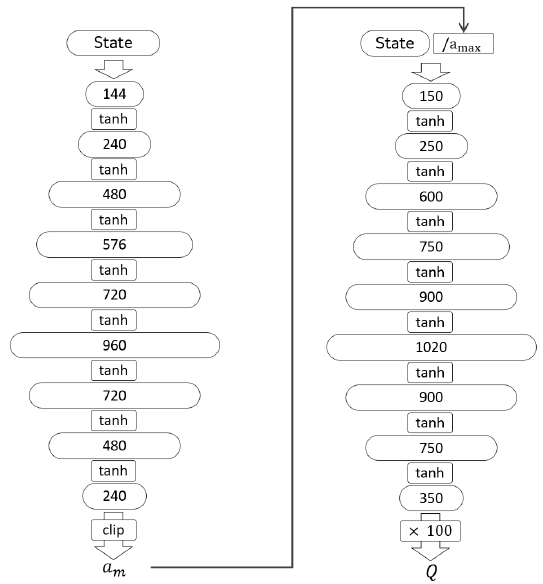
Figure 7. Architecture of the neural